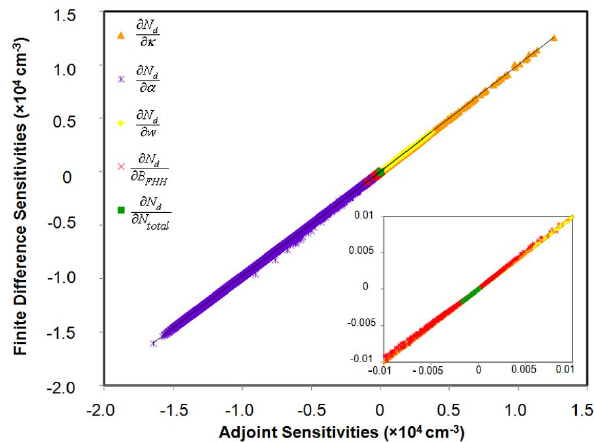
Fig. 2. Adjoint cloud droplet number concentration sensitivities compared to finite difference sensitivities. The inner plot zooms in the − 0 . 01 to 0.01 range. R 2 in all parameters range from 0.9986 to